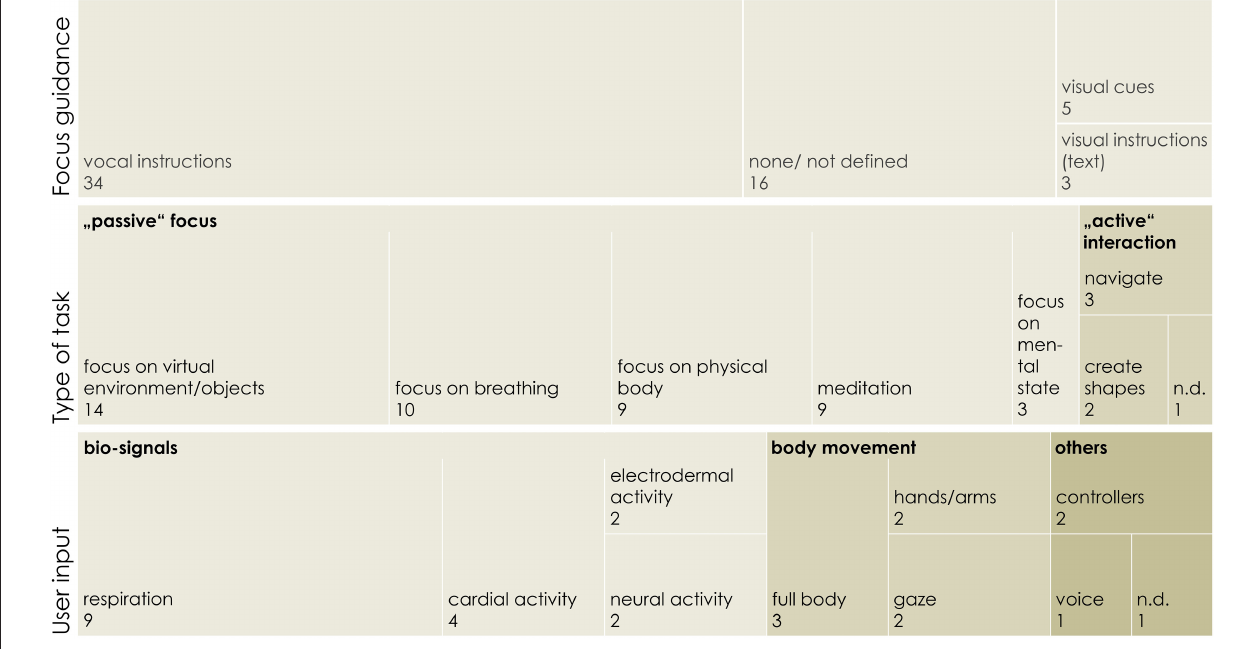
FIGURE 3 | Depiction of the different types of focus guidance, task descriptions, and user input. As some papers included different versions or combinations of guidance, tasks and user input, the numbers do not match the total number of